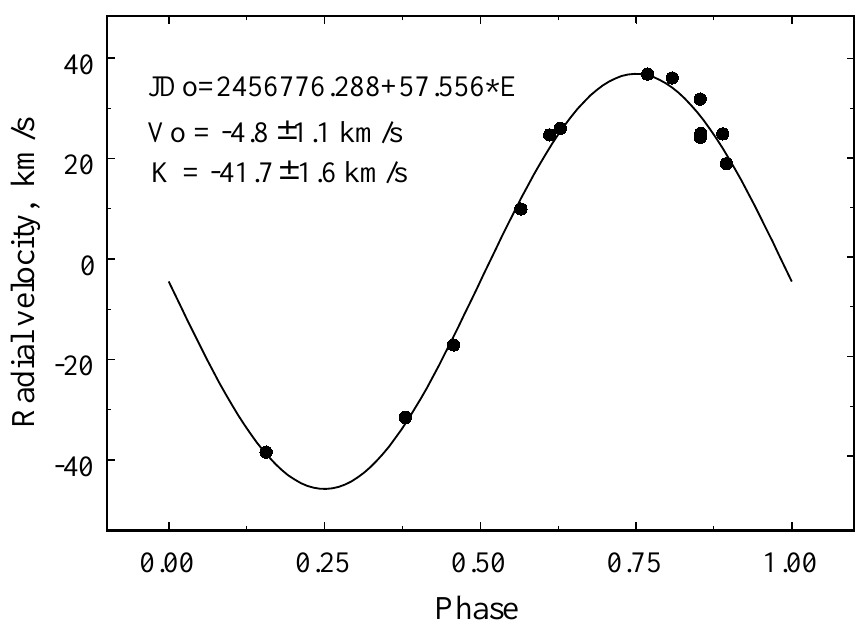
Fig. 2. Radial velocity curve of ADS 2984A (the solid line) fitted to the radial velocity data (dots) obtained for spectral lines of He